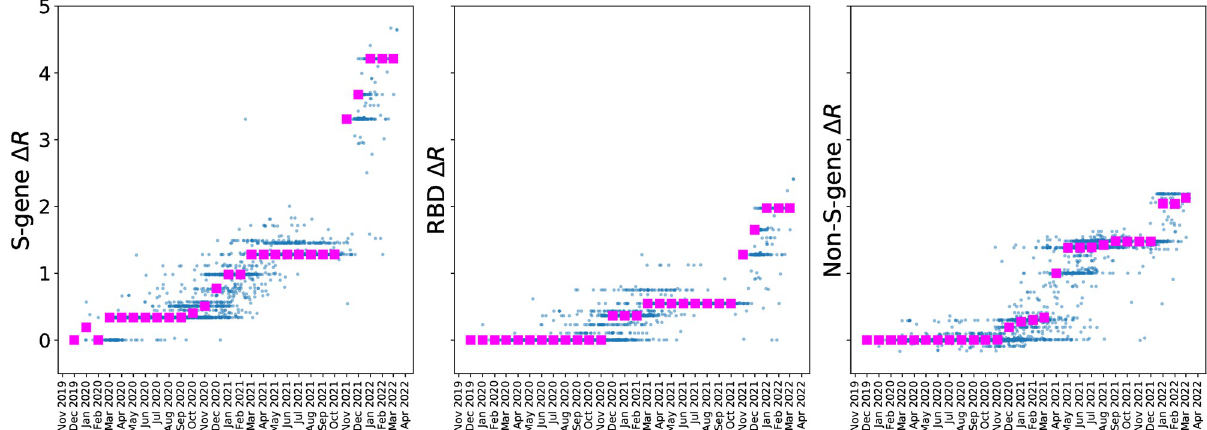
Fig 10. SARS-CoV-2 ‘phase diagram’. We aggregate BVAS β estimates into S-gene (including the RBD), RBD (S gene receptor-binding domain), and non-S-gene components for L = 3000 SARS-CoV-2 clusters (blue points). The horizontal axis denotes the date at which each cluster first emerged, and magenta squares denote the median Δ R within each monthly bin. The elevated contribution of S-gene mutations (notably in the RBD) over non-S-gene mutations starting around November 2021 is conspicuous. Compare to Fig 2CDE in [11].